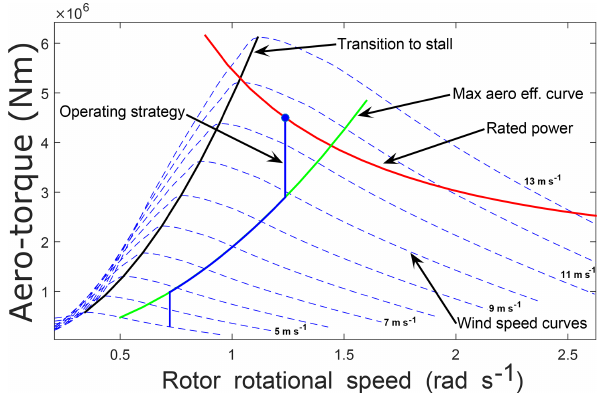
Figure 6. Example torque–speed diagram for a 5MW variable- speed pitch-regulated wind turbine model (Hart, 2018). Pitch con- trol becomes active at the point where the operating strategy reaches the rated power